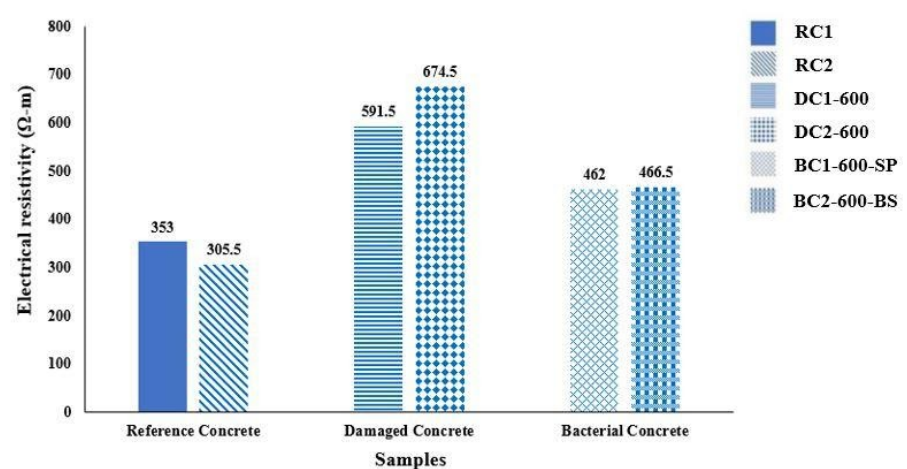
Figure 8. Comparing the bulk electrical resistivity results of the control specimens, damaged at 600 °C and repaired by type I and II bacteria.